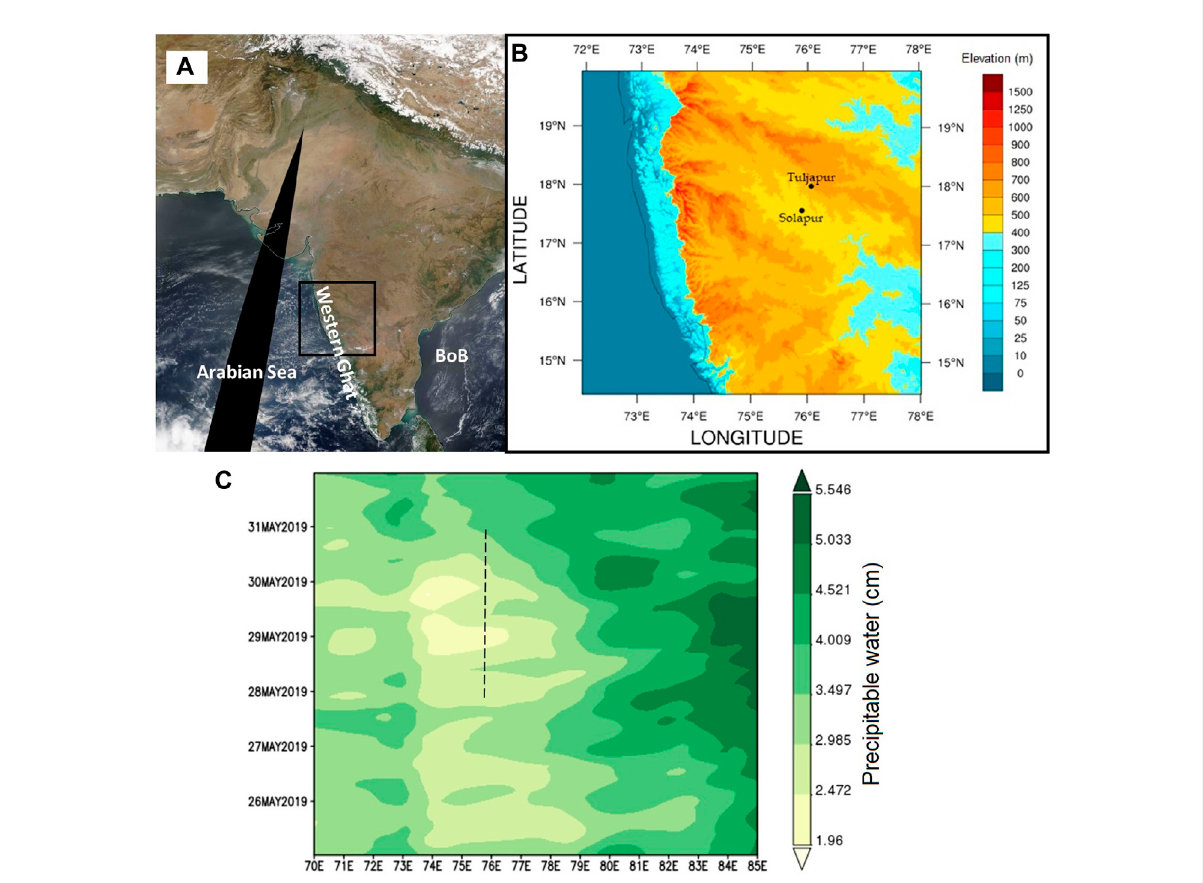
FIGURE 1 (A) Satellite image of the Indian subcontinent on 26 May 2019 from MODIS EOSDIS Worldview. (B) Terrain map (zoomed part of thebox shown inpanel (A) showingthelocationofthemeasurement sites,Tuljapurand Solapur, intherain shadowregionof theWestern Ghats. (C) The Hovmoller diagram of the precipitable water. Dashed line in the panel (C) indicates the location and duration correspond to the present study. Hovmoller diagram is generated using hourly averaged data over the region (17 – 20.5 ° N) and (70 – 85 ° E) for the period 25(00UTC)-31(23UTC) May 2019 (0.5 × 0.625 degree resolution data from MERRA-2 Model M2T1NXLND v5.12.4